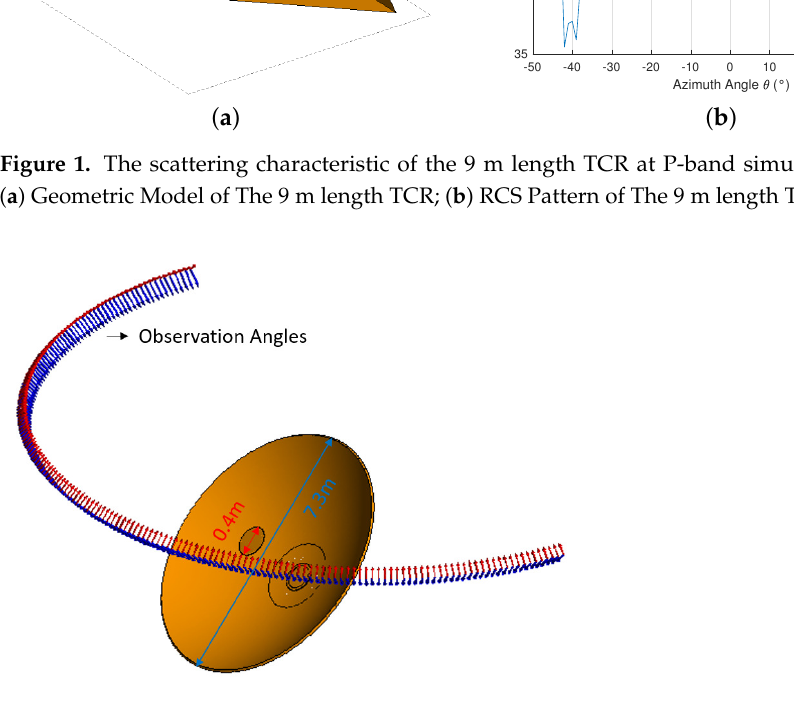
Figure 2. The geometric model of the parabolic antenna.